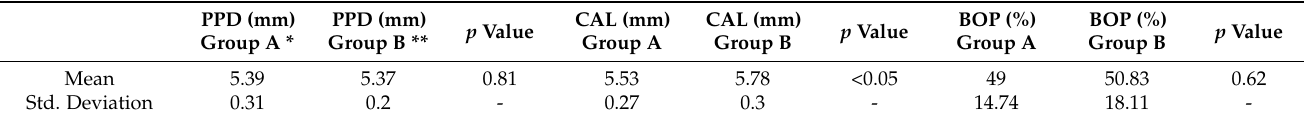
Table 2. Baseline clinical periodontal parameters of both